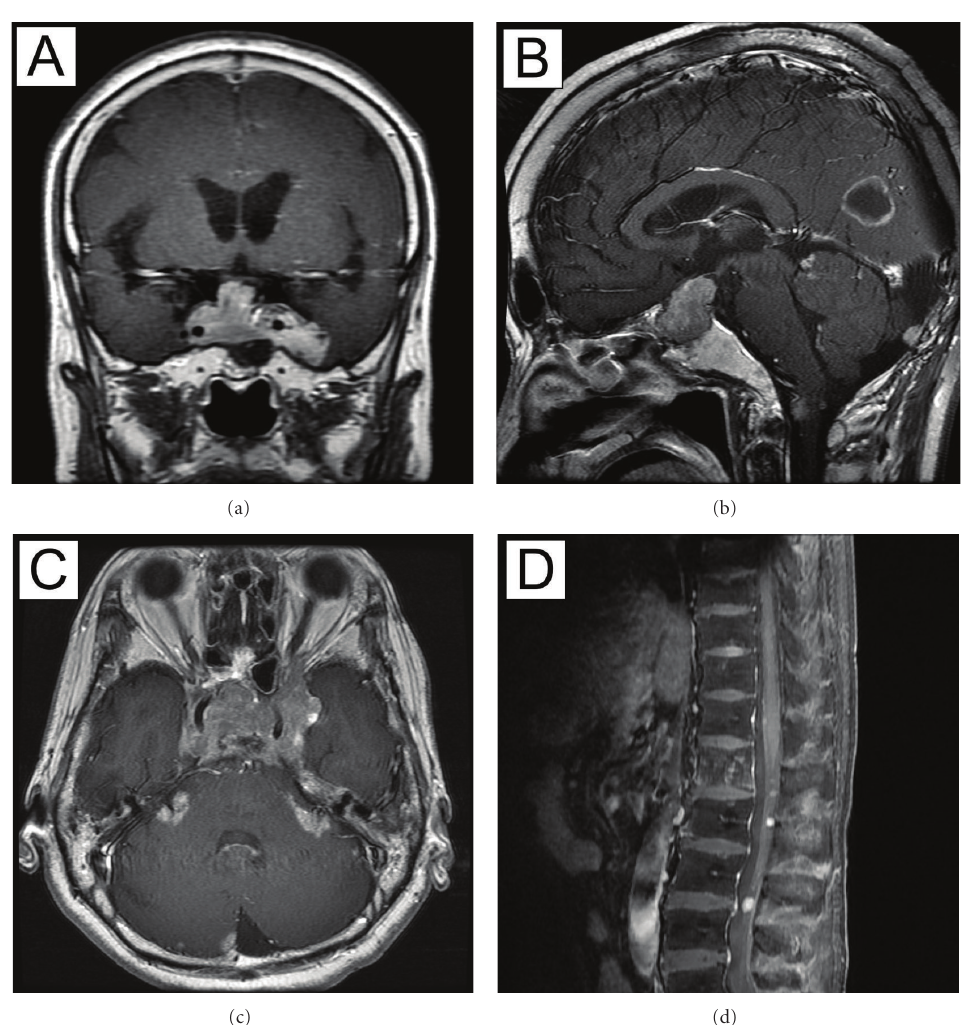
Figure 1: Pituitary carcinoma before the treatment. The pituitary tumor surrounds the bilateral cavernous sinus and protrudes close to the optic chiasm (detected by contrast-enhanced MRI). The tumor invades the left temporal lobe (a). Metastatic brain tumor in the occipital lobe shows ringlike enhancement (b). The pituitary tumor shows meningeal dissemination (c). Metastatic tumor in the L1 and di ff use meningeal dissemination